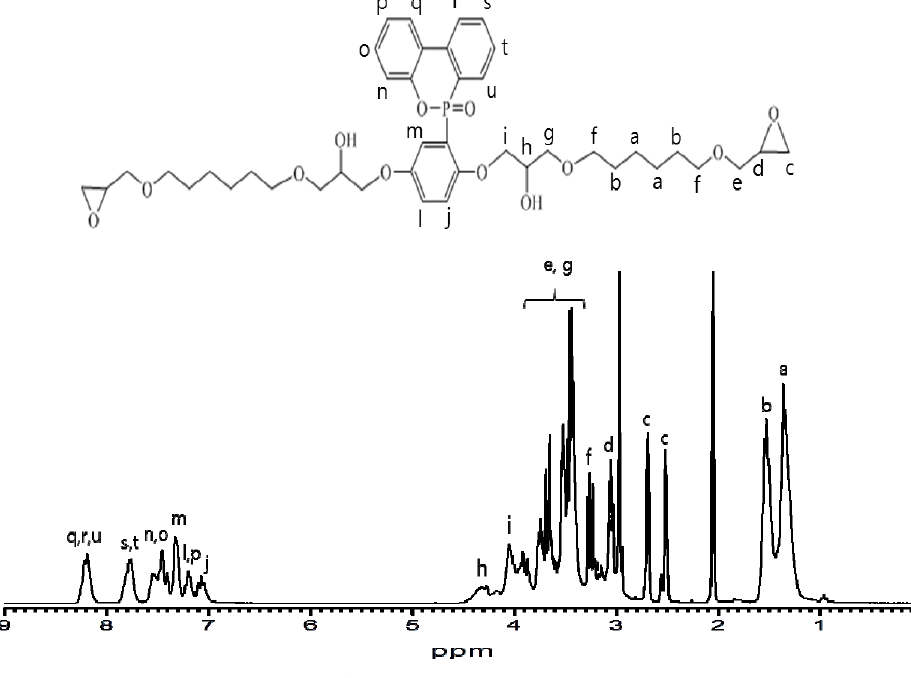
Figure 2. 1 H-NMR spectrum of EP-DOPO.